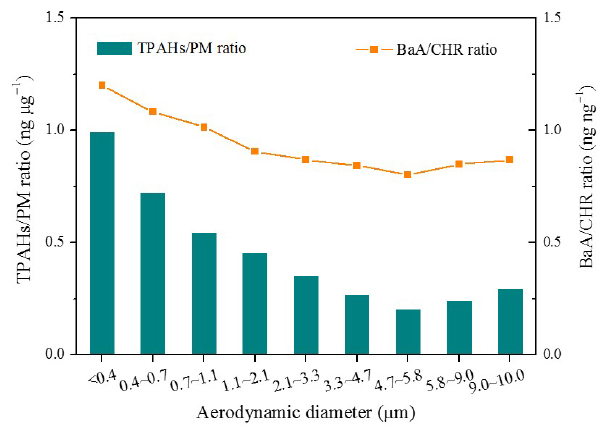
Figure 4. Ratios of total PAHs / PM (ngµg − 1 ) and BaA / CHR (ngng − 1 ) across particle